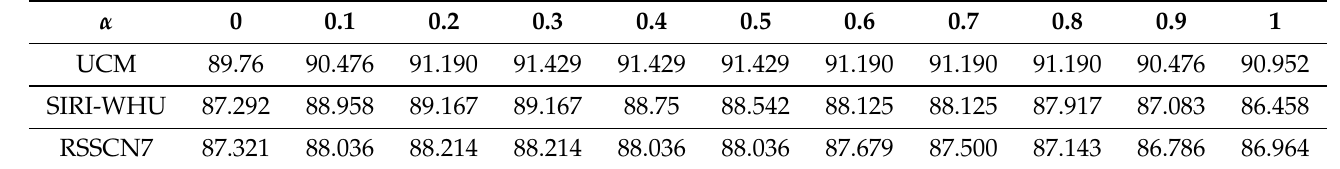
Table 7. The experimental results at different α on the three